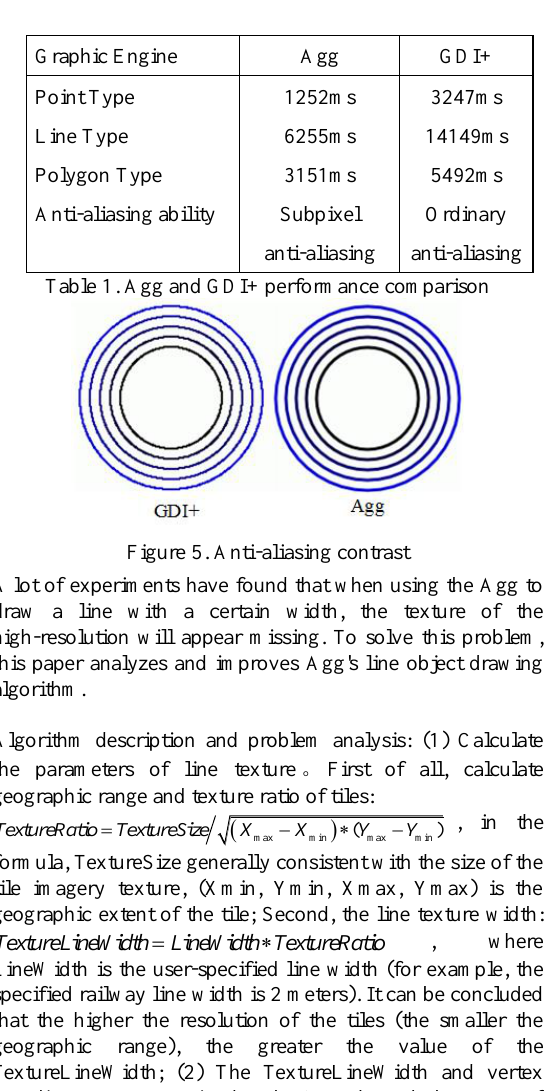
Figure 7. The correct fusion of high